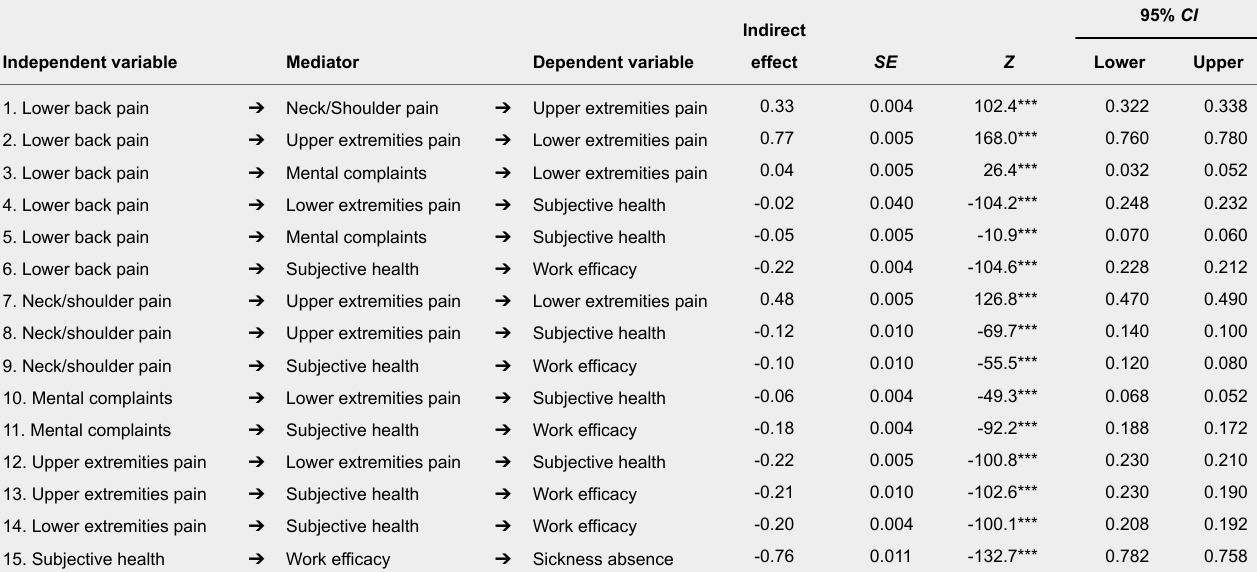
LISREL Tests of Indirect Associations Emerging in Figure